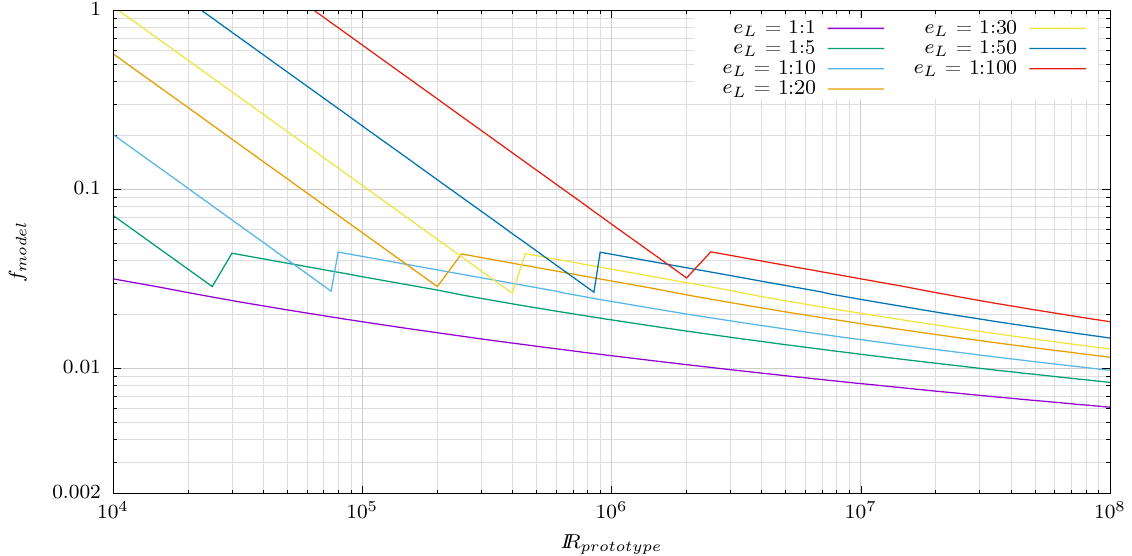
Figure 1: Friction factor for hydraulically smooth circular pipes. Prototype versus physical models at different scales.